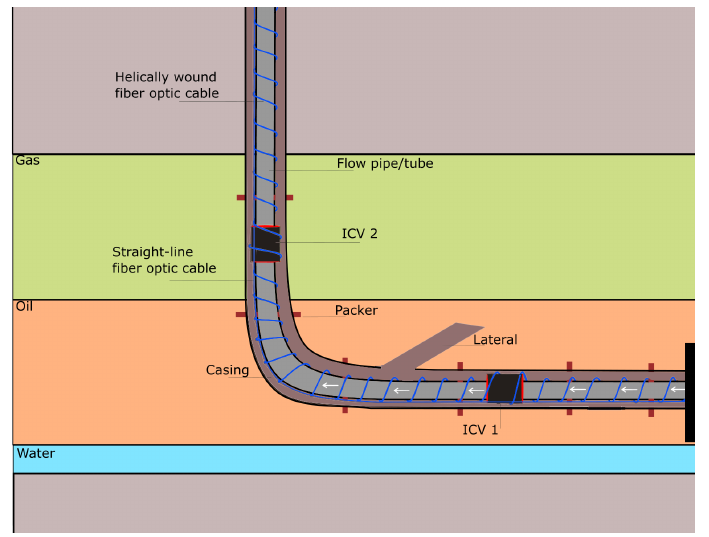
Figure 4. A sketch of a smart well with ICVs and fibre cables mounted around the flow